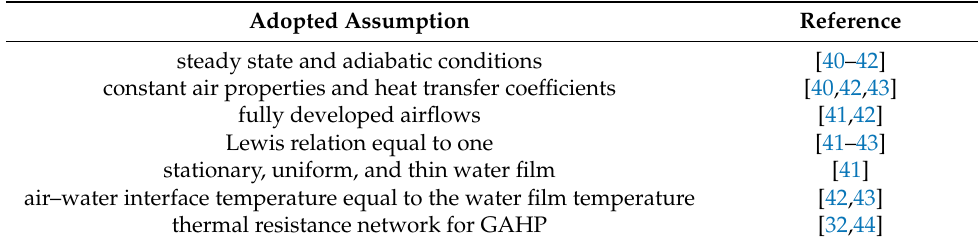
Table 4. Assumptions made to simplify the mathematical model.